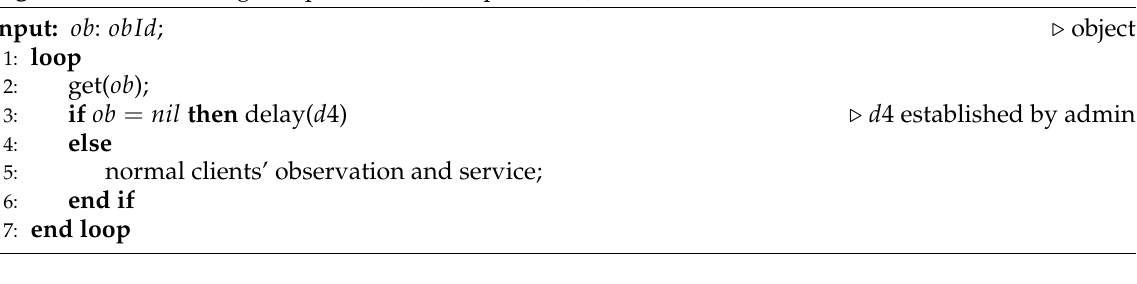
Algorithm 5 The QA agent operations (QA-operations).